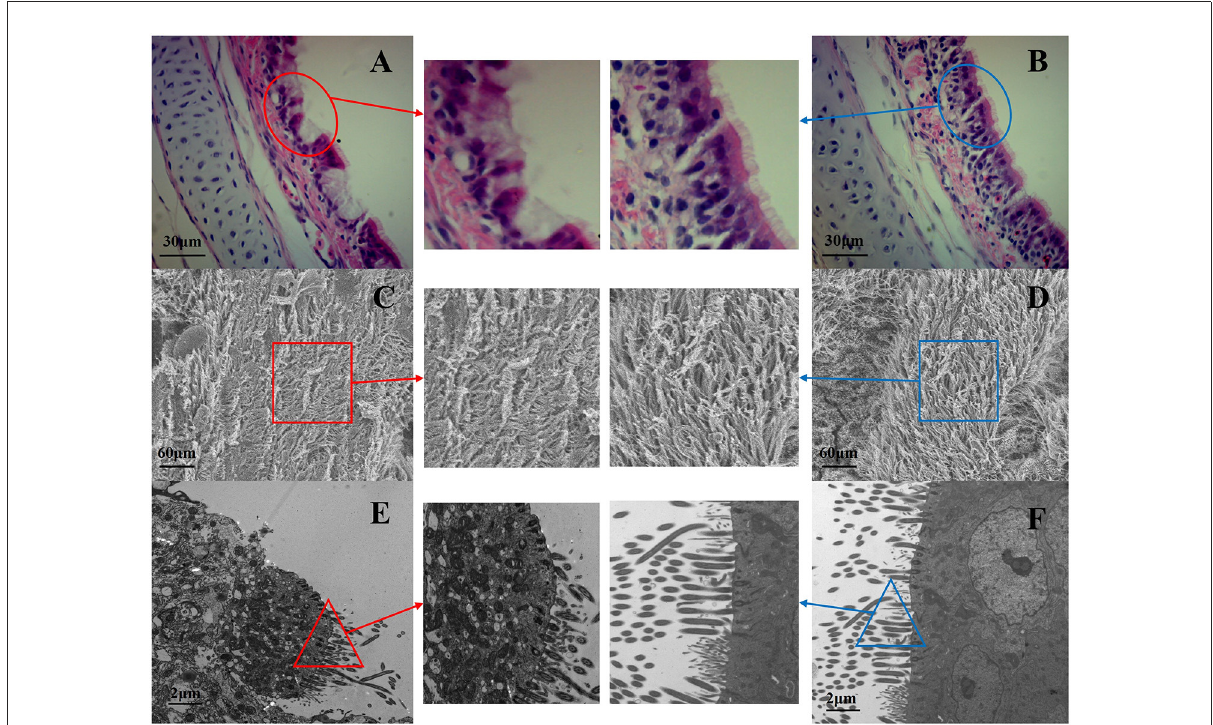
FIGURE5 Pathological and ultrastructural changes of NCMC treatment on chicken trachea, ( A,C,E from the co-infection group; B,D,F from the NCMC treatment group). Paraffin sections of tracheal tissues from co-infection group and co-infection + NCMC group were stained with hematoxylin-eosin (100 × ). (A) The red circle shows the cilia are exfoliated and there is a proliferation of goblet cells. (B) The blue circle indicates that the cilia are well arranged and only a small amount of inflammatory cell infiltration. SEM of (C,D) at a magnification of 2,500 × , and TEM of (E,F) at a magnification of 8,000 × . (D) The cilia in blue square significantly more abundant and intact after treatment of co-infection (C) . (E) The cilia were ruptured, matrix electron density decreased in red triangle of co-infection group. (F) The blue triangle shows some cilia were shed, but the symptoms of the treatment group were significantly